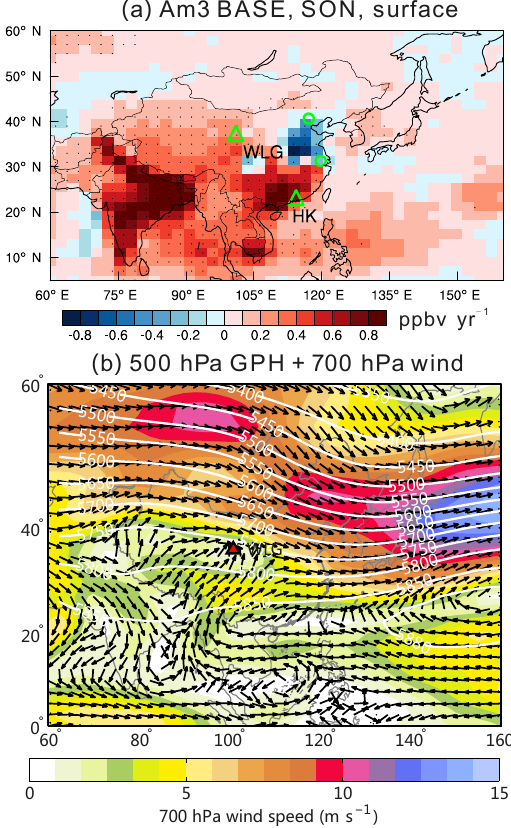
Figure 7. (a) The 1995–2014 trends of autumn average daily maxi- mum 8h average ozone sampled in the surface level from the GFDL AM3 model with time-varying anthropogenic emissions (BASE). Stippling indicates areas where the trend is statistically significant at the 95% confidence level. Green symbols denote the locations of WLG, Hong Kong, Shangdianzi, and Lin’an. (b) Mean 700hPa wind speed (colour shading), direction (black arrows), and 500hPa geopotential height (contours) in autumn averaged over the 1994– 2013